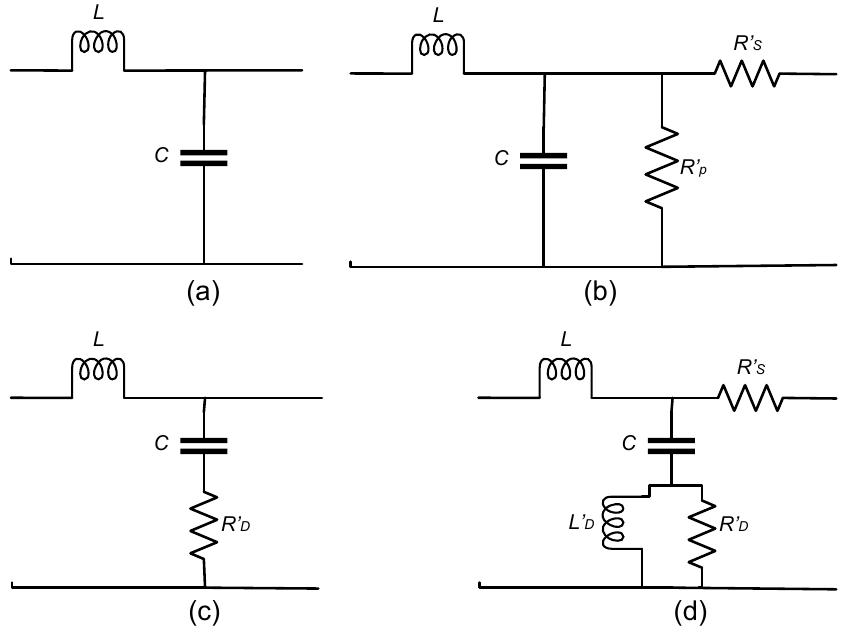
Figure 3. Schematic of ( a ) the standard transmission line model ( b , c ) improvements to the transmission line model, and ( d ) the distributed capacitor model formed on the basis of the standard transmission line model.